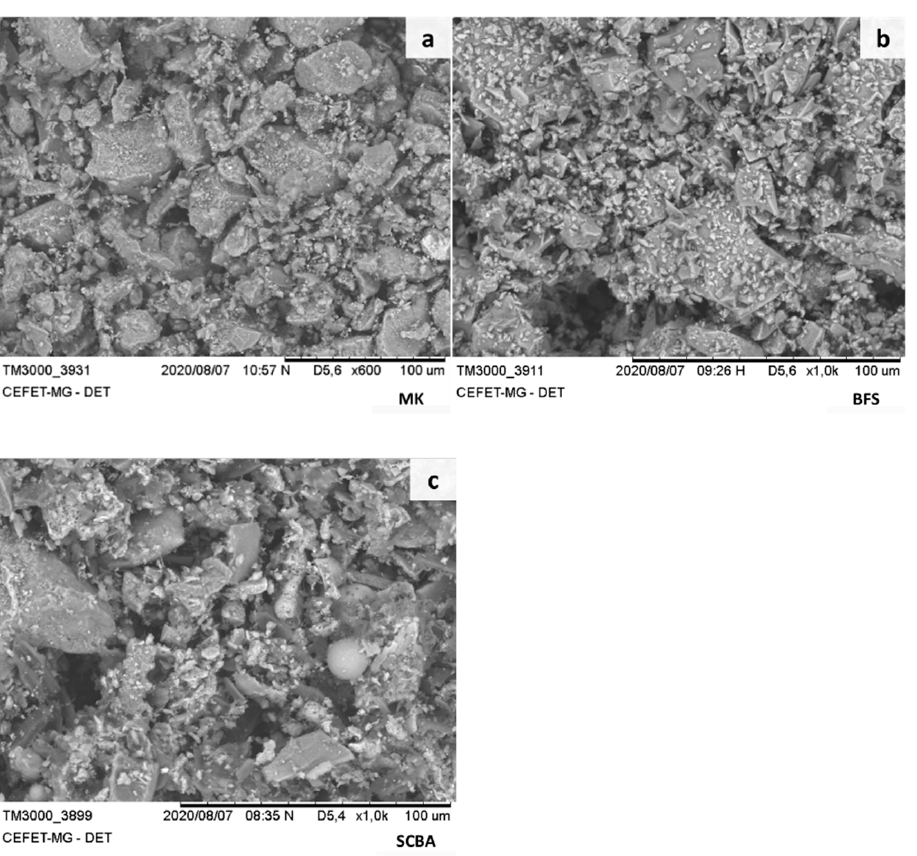
12 of 18 Figure 12. FTIR image spectra of MK, BFS and SCBA. Morphology of precursors particles were observed that BFS and MK had particles